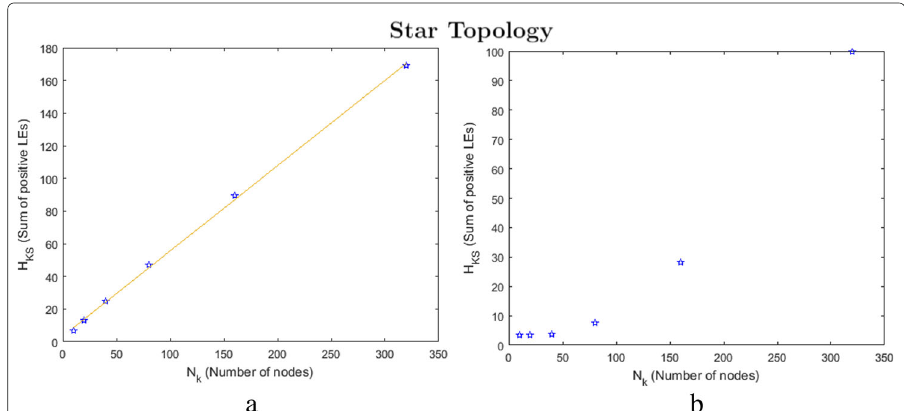
Fig. 4 The sum of positive LEs with respect to the number of nodes for networks with star topology that do not satisfy cases 1 and 2, respectively. For each network we considered the building block with N 0 = 5 and ε = 2 · 10 − 4 . In ( a ) the inter-coupling of the network (cid:2) ( 1 ) is γ( 1 ) = 0.05 and in ( b ) γ( 1 ) = 0.5045 and k = [1,2, ... ,6]. In both graphs, during the evolutionary process the inter-coupling strength was kept constant. The fitting in the orange line in ( a ) produces p 1 = 0.5223 and p 2 = 3.3490, where p 1 is the slope and p 2 is the constant coefficient of the fitting